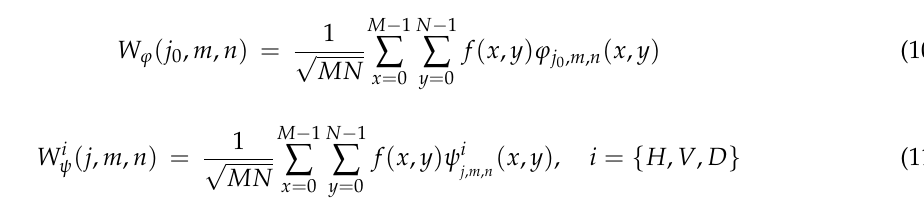
H  corresponds to some variations along V  corresponds to variations along rows (for example, vertical